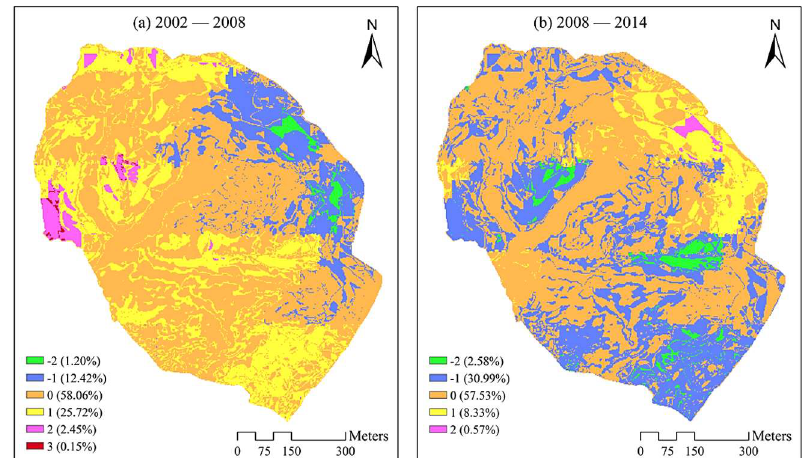
Figure 5. The spatial dynamics of soil erosion in the Wangjiagou agricultural watershed during the two time intervals (where 0 represents no change in the soil erosion intensity level and the 1 represents that the intensity level has moved to a higher level (i.e., from severe to very severe or from slight to moderate). The 2 represents that the intensity level moved to a higher level twice and the 3 represents that it moved to a higher level thrice. Moreover, − 1 means that the intensity level has moved to a lower level and − 2 means that it moved to a lower level twice.). Table 4. The transition probability matrix of soil erosion intensity in the Wangjiagou agricultural watershed from 2002 to 2008.